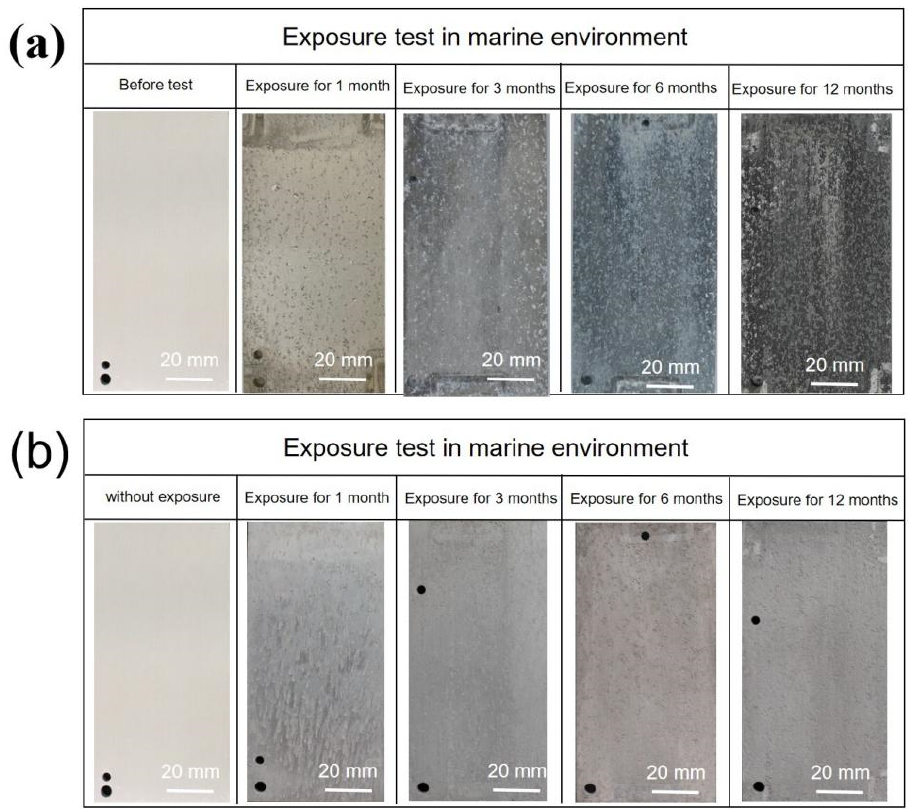
Figure 6. Surface appearance of AZ31 magnesium alloy specimens exposed for different periods in marine environment of ocean voyage: ( a ) with corrosion products, ( b ) without corrosion products.